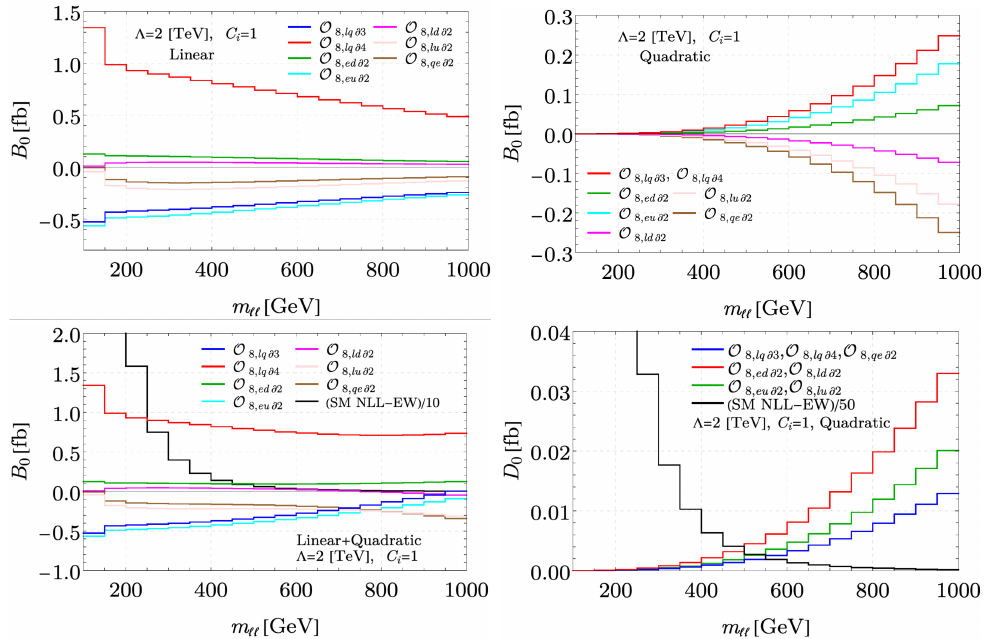
Figure 2 . Individual operator contributions to the differential distributions for the B 0 and D 0 angular moments, setting Λ = 2 TeV and the Wilson coefficient C i = 1 . Upper left : B 0 contributions linear in C i . Upper right : B 0 contributions quadratic in C i . Lower left : sum of the linear and quadratic contributions in C i to B 0 . The SM NLL EW prediction is also shown, scaled by a factor 0.1 Lower right : D 0 contributions quadratic in C i (there are no linear contributions). The SM NLL EW prediction is also shown, scaled by a factor 0.02.